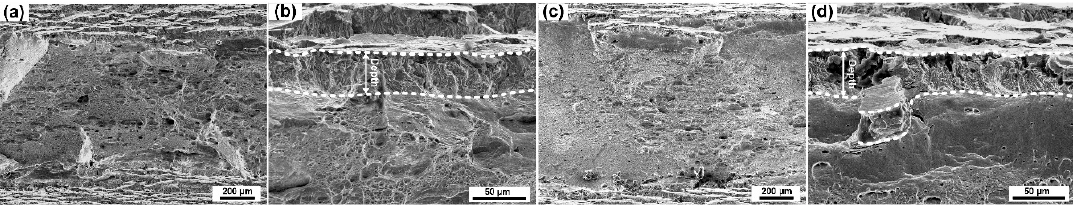
Figure 9. SEM surfaces of 304L specimens. ( a , b ) Prestrained to 30% at 20 °C; ( c , d ) prestrained to 30% at 50 °C; ( e , f ) prestrained to 30% at 80 °C.